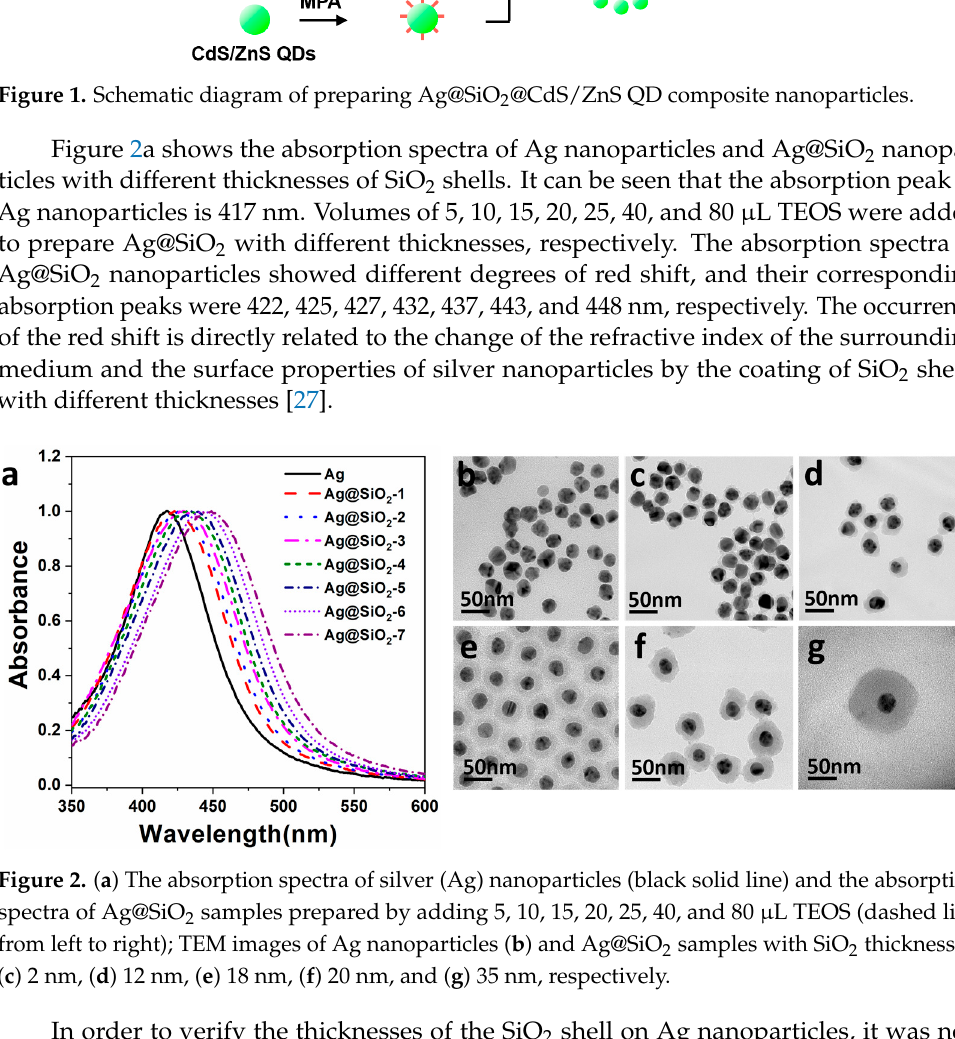
Figure 1. Schematic diagram of preparing Ag@SiO 2 @CdS/ZnS QD composite nanoparticles.